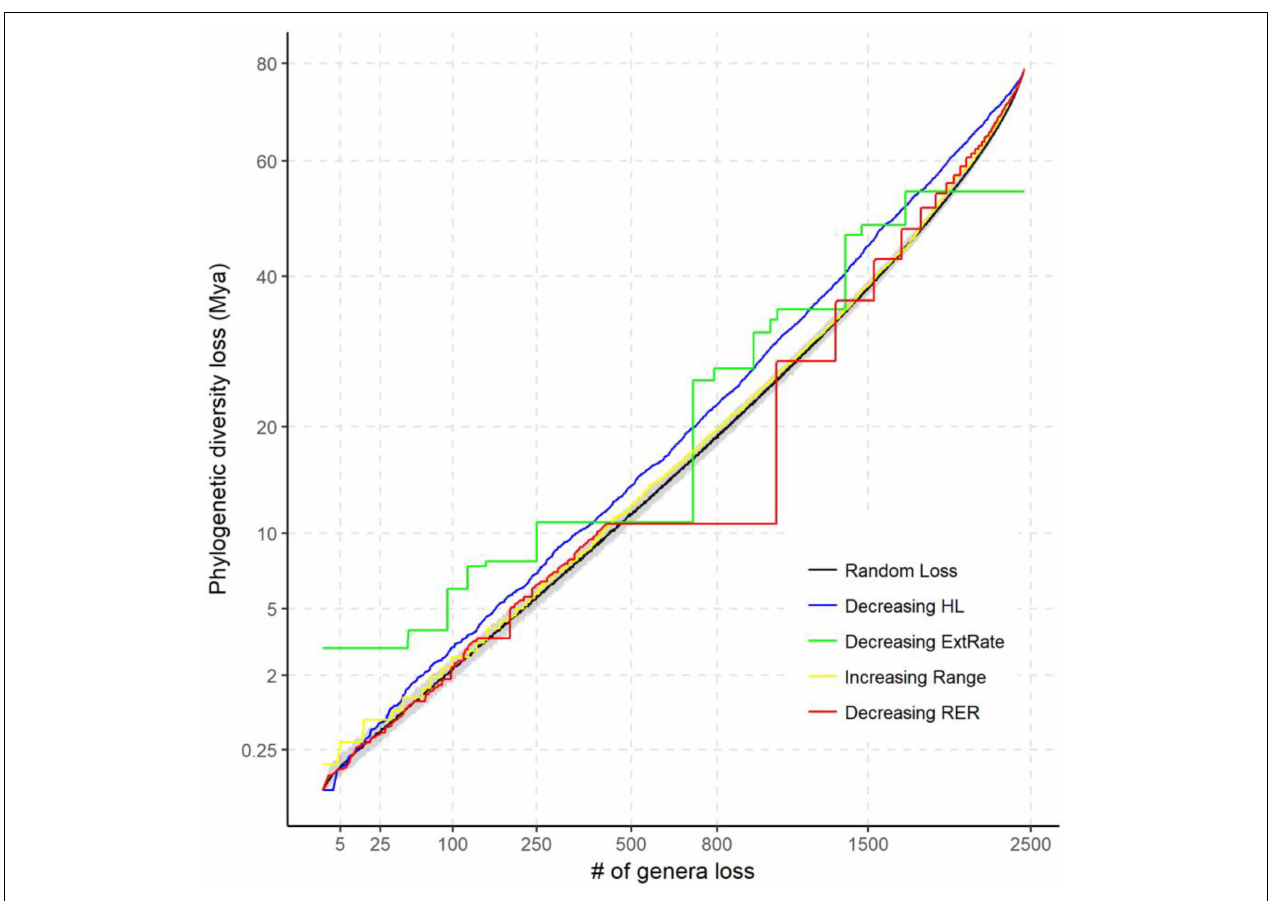
FIGURE 5 | The potential loss of phylogenetic diversity (PD) under different extinction scenarios compared with random extinction on the tree of life for Chinese angiosperms. The black solid line shows the median of expected PD loss by randomly pruning the same number of genera from the genera phylogeny 1,000 times. The gray area is the quantile range (2.5–97.5%) of the null model. The extinction scenarios include: decreasing habitat loss (HL) (blue line), decreasing relative extinction rate (green line), increasing range size (yellow line), and decreasing reduction of extinction risk (RER) (red line). Axes are square-transformed to facilitate